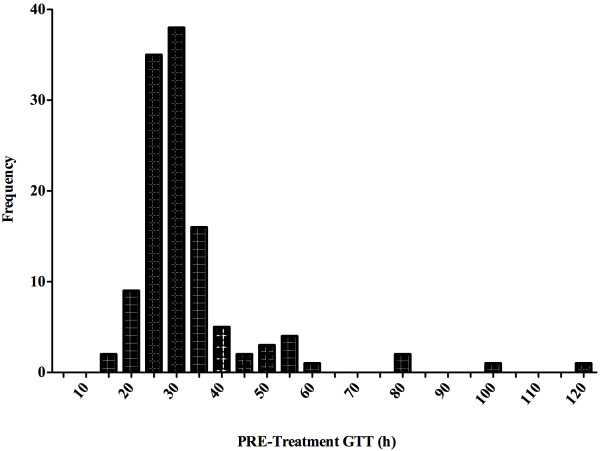
Histogram depicting the distribution of PRE-treatment GTT 1. Abbreviations: GTT, gastrointestinal transit time. 1 Distribution of PRE-treatment GTT values, measured in duplicate in two separate GTT assessments, for each participant (n = 65).